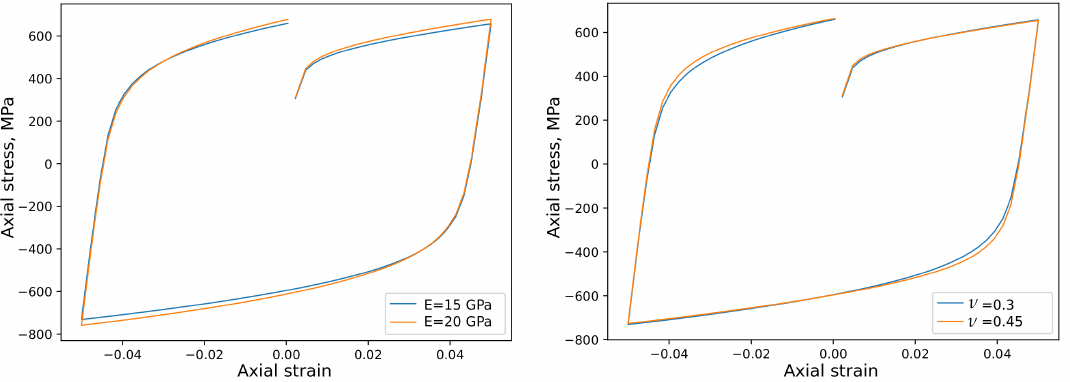
Figure 9. Sensitivity analysis of graphite elastic parameters. Single stress–strain hysteresis loop for the cast iron model. ( Left ): different Young’s modulus ( ν = 0.3); ( right ): different Poisson’s ratio ( E = 15